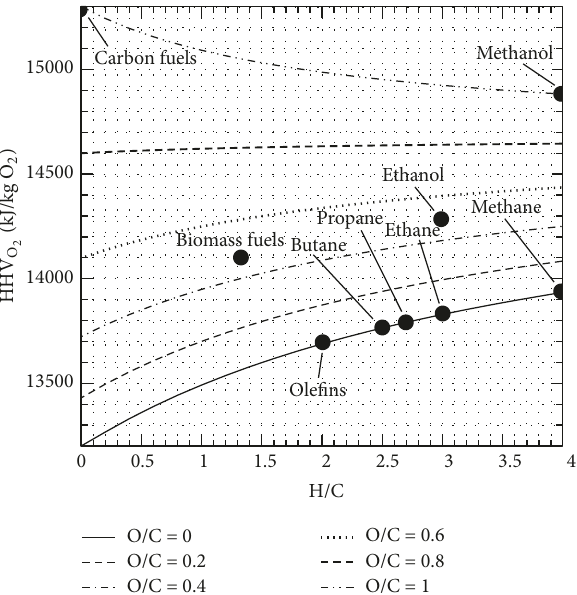
Figure 2: Variation of higher heating value of fuels per kg of oxygen consumed with increase in H/C ratio in fuels. It can be seen that HHV almost remains constant for all fuels. 𝑌 scale is enlarged to O 2 show small deviations; multiply HHV in kJ/stoich kg of O 2 by 0.43 O 2 to obtain BTU/stoich lb of O 2 . Multiply HHV in kJ/stoich kg of O 2 O 2 by 0.0013 to obtain kJ/SATP liter and multiply kJ/kg by 0.035 to obtain BTU/SATP SCF of O 2 where SATP is standard atmospheric temperature and pressure, 25 ∘ C and pressure of